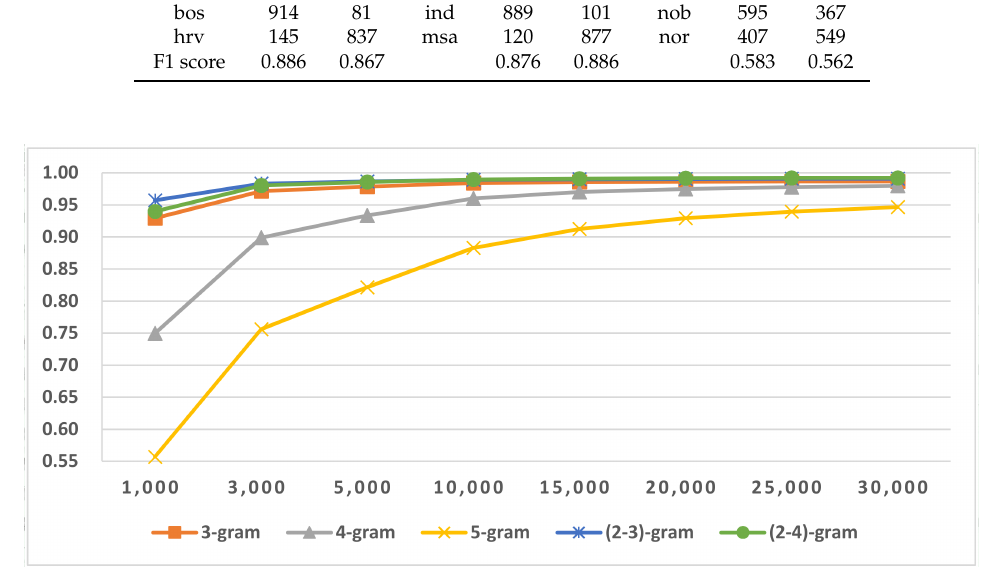
Figure 11. Results of LI (SLGI) in Latin script